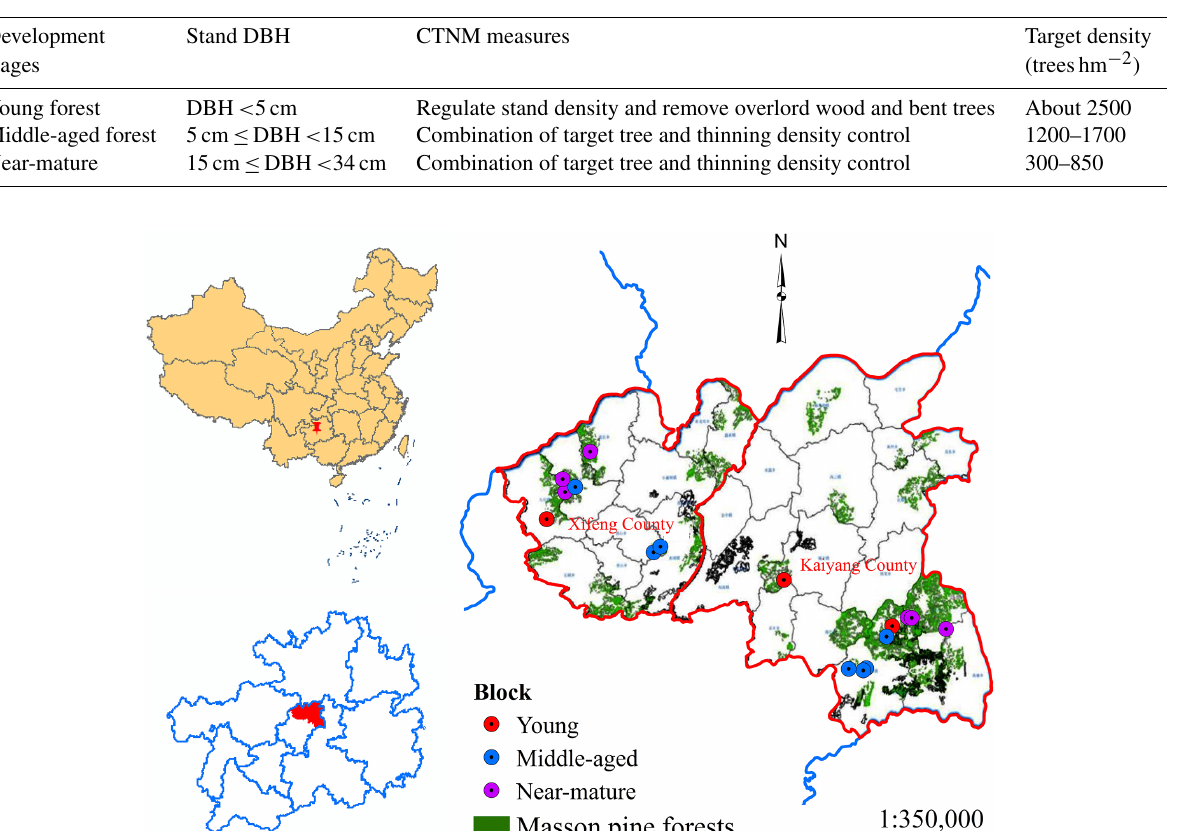
Table 1. Close-to-nature management measures at different development stages of Masson pine plantations.